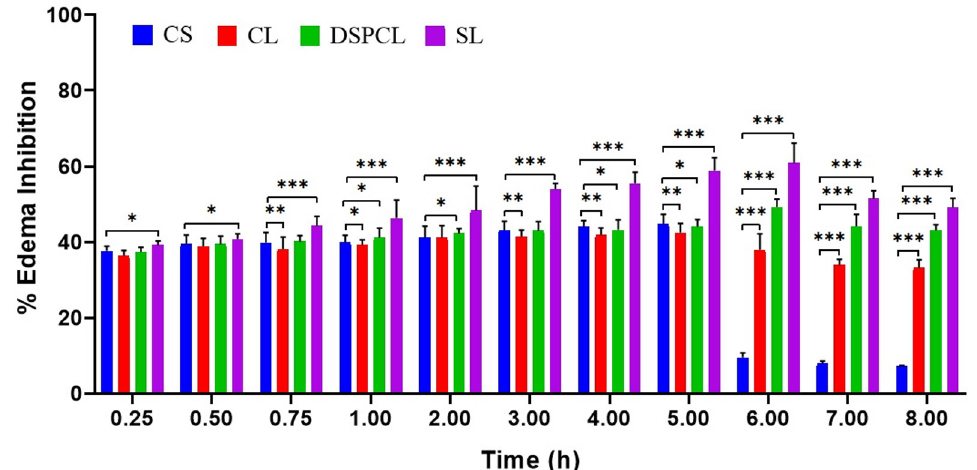
Fig 8. Inhibition percentage of CLB conventional liposome (CL), CLB DSPC liposomes (DSPCL) and CLB stealth liposomes (SL) compared to free CLB solution (CS) (data expressed as mean ± SD, n = 6; � p < 0.05, �� p < 0.01, ��� p <